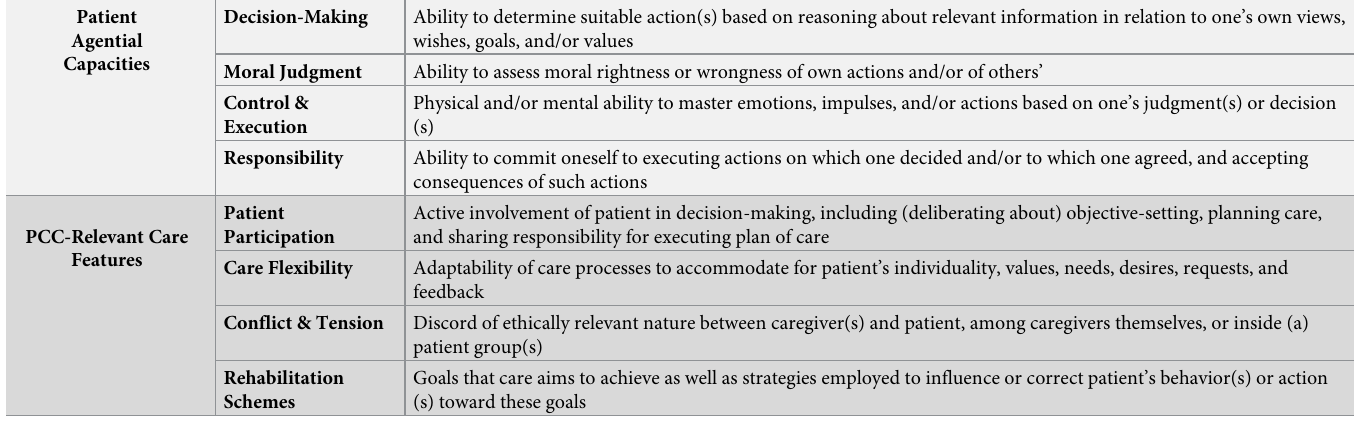
Table 1. Definitions of framework categories, under two broad headings of patients’ agential capacities and care features of relevance to